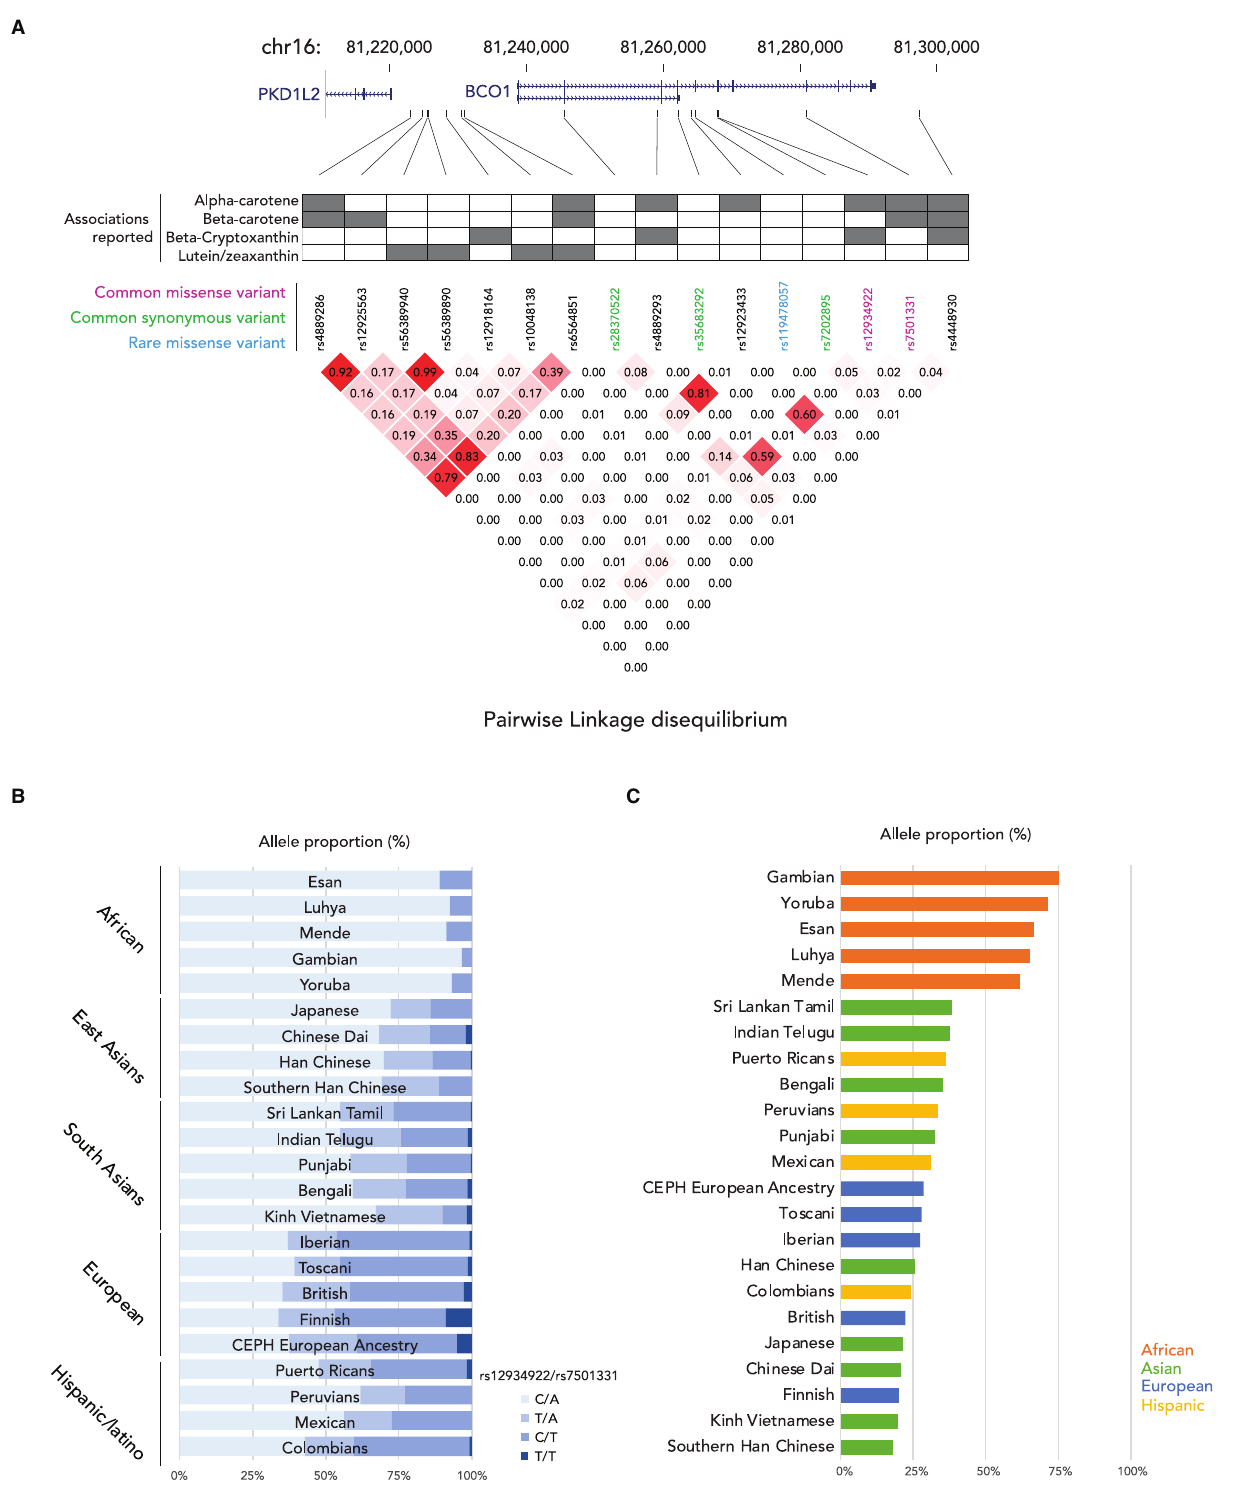
Frontiers in Nutrition |